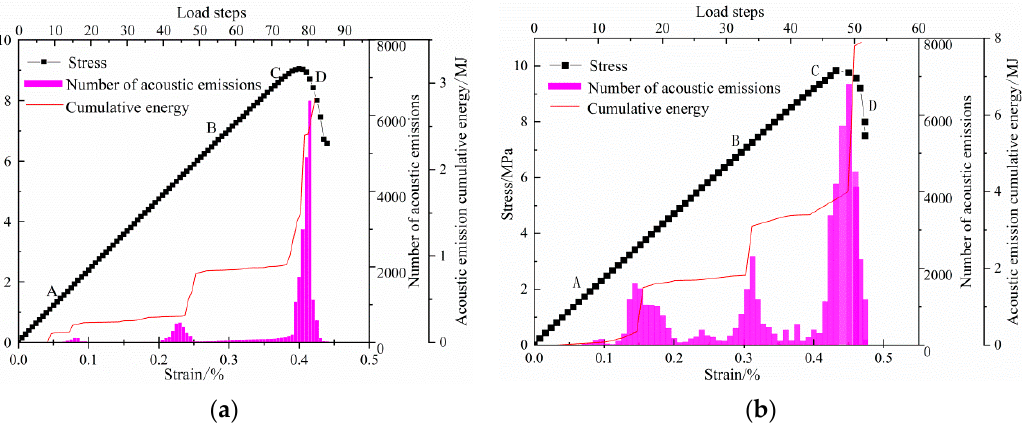
Figure 10. Stress–strain relationship and acoustic emission laws with loading steps with ( a ) the specimen with top joint, and ( b ) the specimen with middle joint.